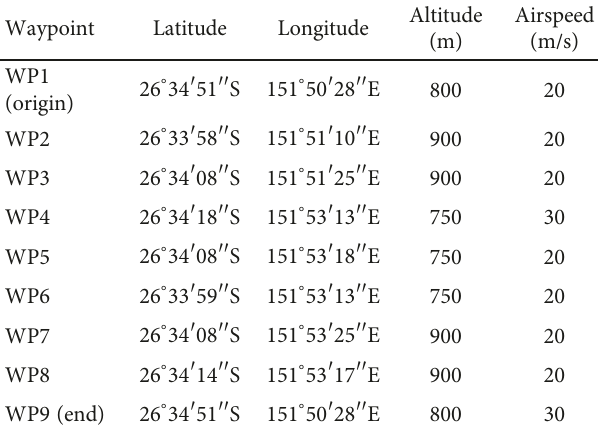
Table 3: Waypoint information of mission scenario. Waypoint